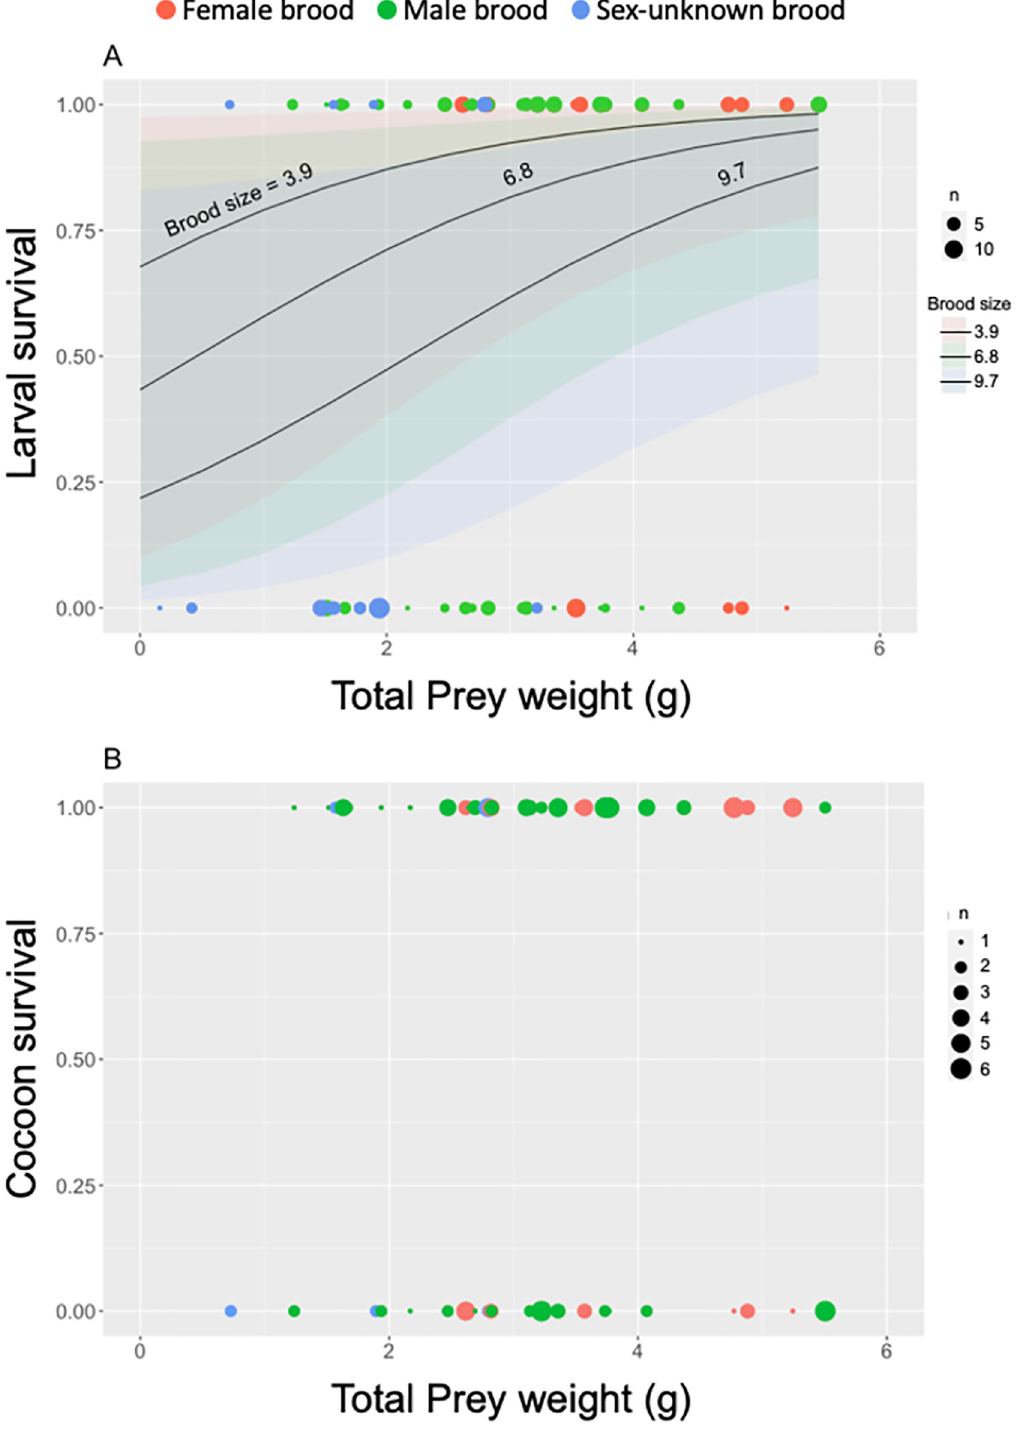
Fig 4. Relationship between survival of individual wasp offspring and total prey weight per brood in whole brood rearing experiment. Survival of wasp offspring were shown during eggs or early larvae to cocoon stage (A) and during cocoon to adult emerging stage (B). Logistic regression lines with 95% confidential intervals were fitted to female brood data at three values of brood sizes (3.9, 6.8, and 9.7) for larval survival, indicating a significant positive effect of total prey weight and a significant negative effect of brood size on larval survival. There was no relationship between cocoon survival and total prey weight or brood